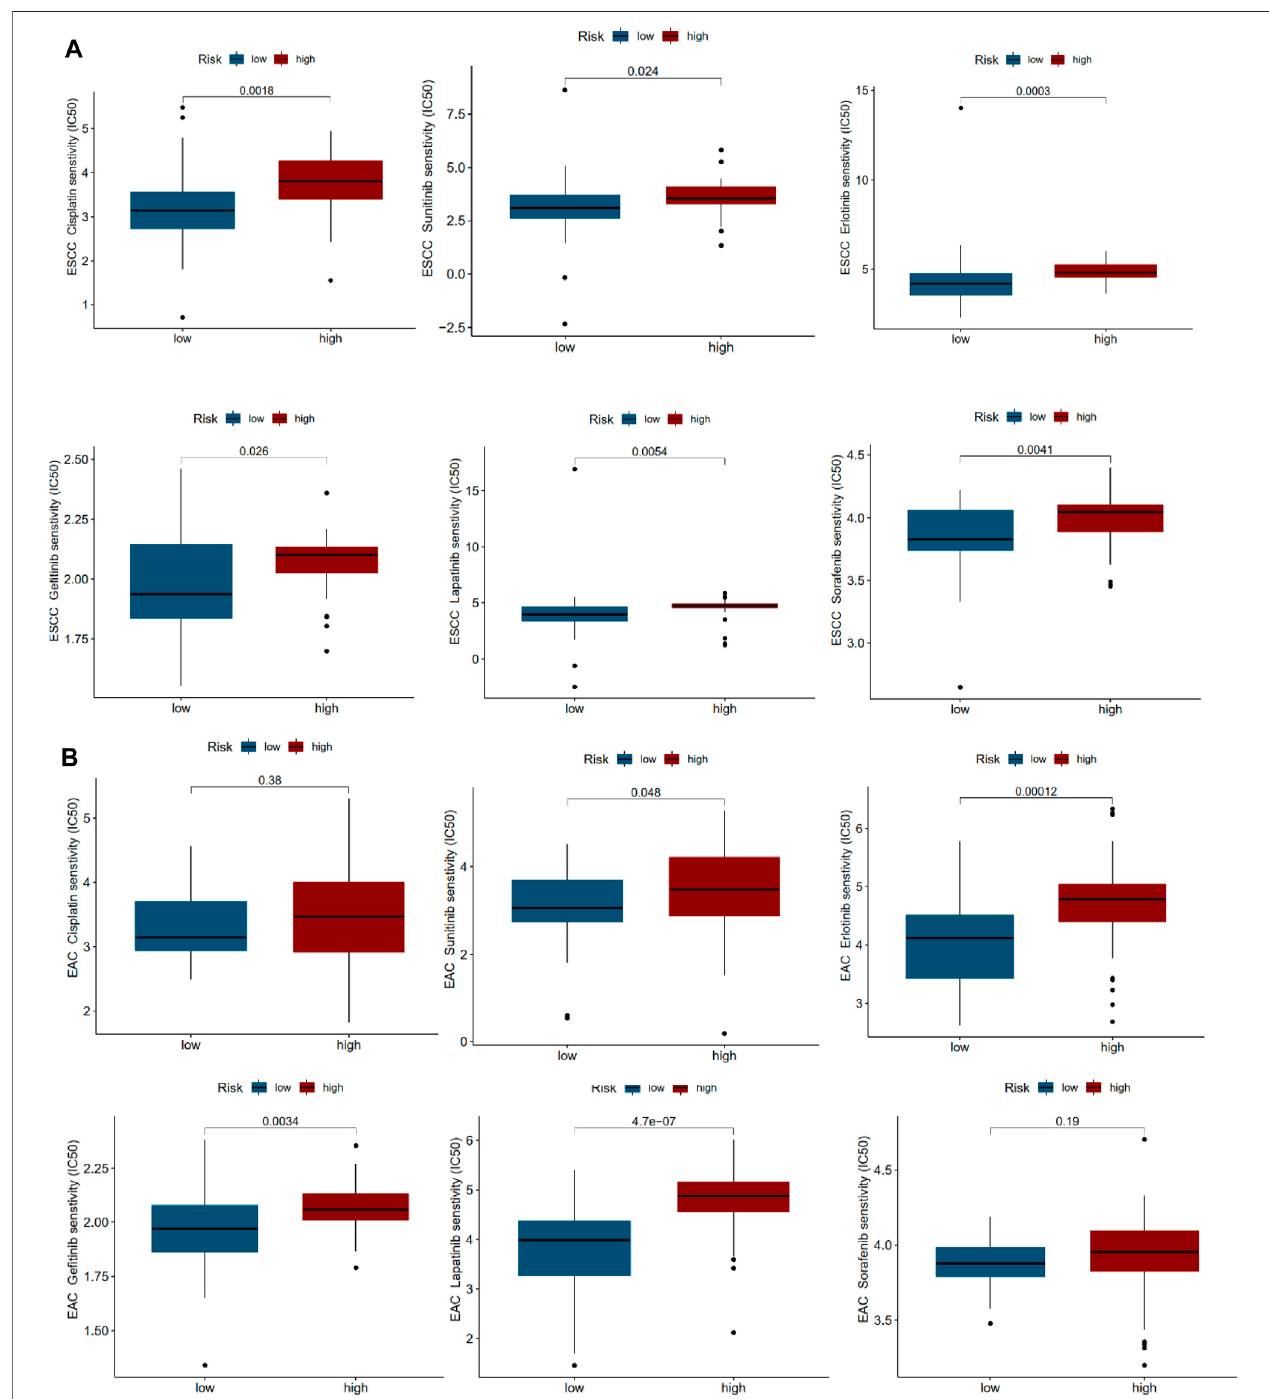
FIGURE6| Drugsensitivitycorrelatedwithhigh-andlow-riskpatientsinESCCandEAC. (A) IC 50 valuesofvarious drugsinhigh-andlow-riskpatientswithESCC. (B) IC 50 values of various drugs in high- and low-risk patients with EAC.